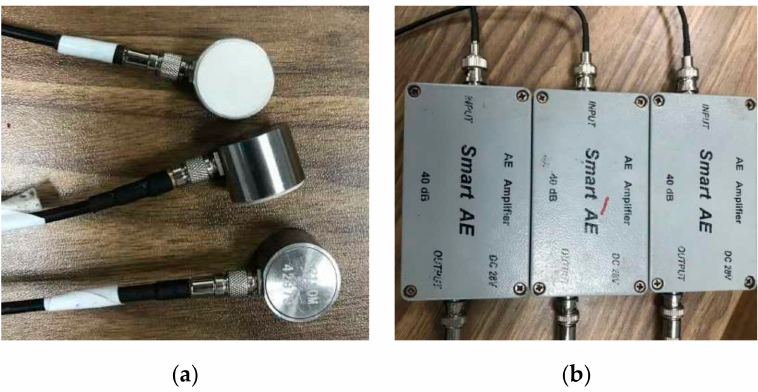
Figure 7. AE sensors and AE amplifiers. ( a ) AE sensors, ( b ) AE